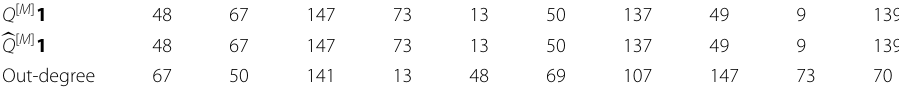
Table 1 Enron: Top 10 ranked nodes: exact, approximate and with aggregate out-degree Q [ M ] 1